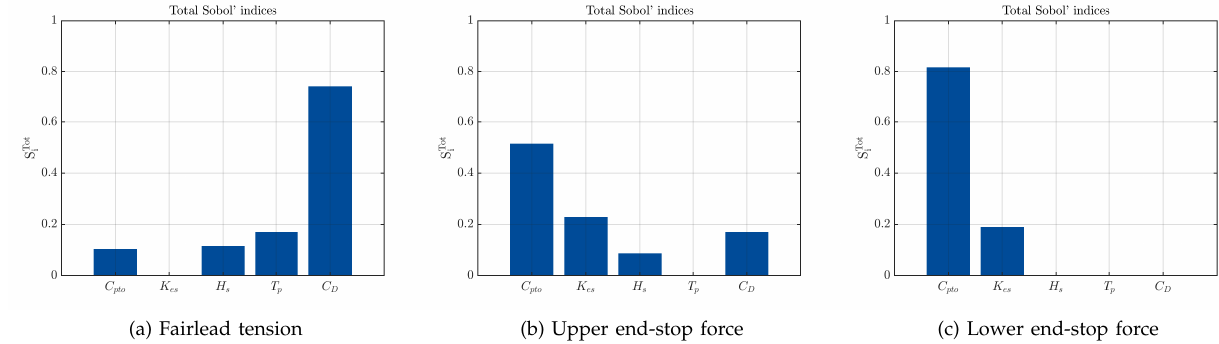
Fig. 12. Total sensitivity index for the SS1 case using d = 5 .